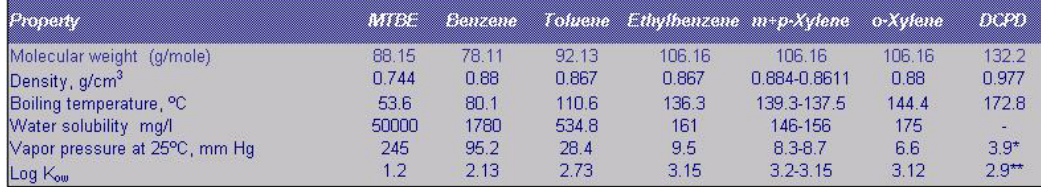
Physical-Chemical